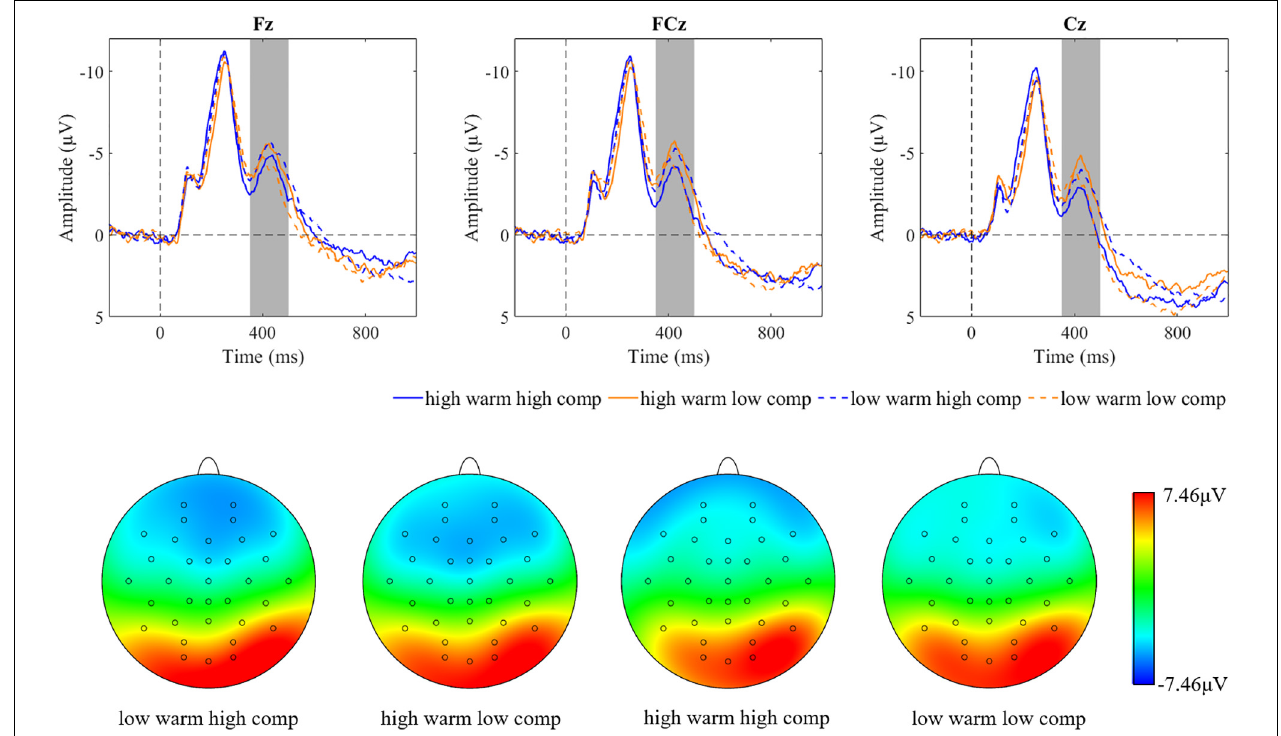
FIGURE 8 | Brainwaves and scalp topographies of the N400 activity for four